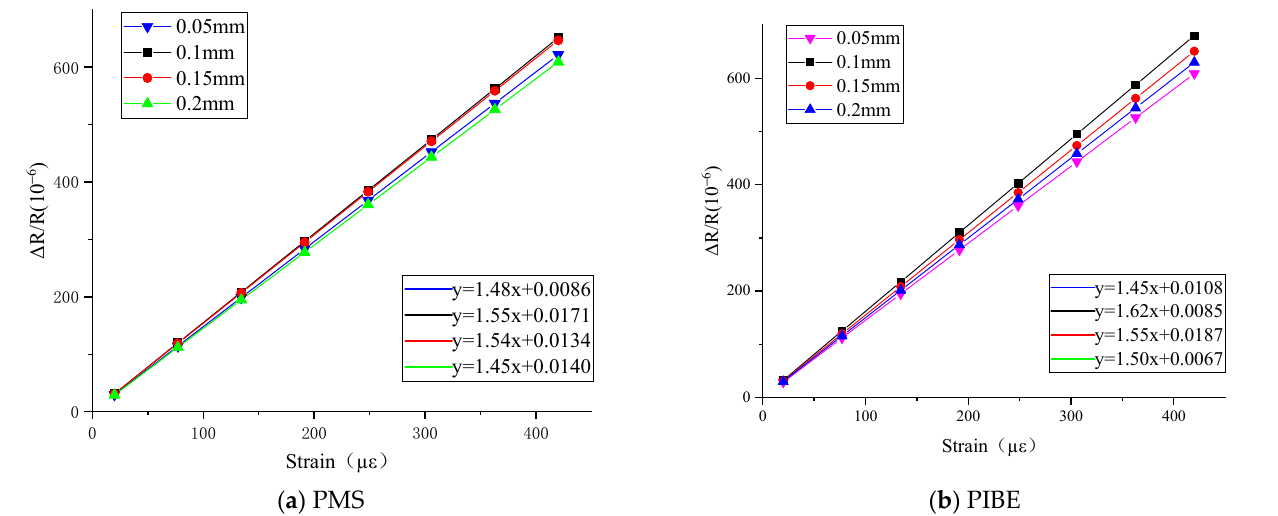
Figure 6. Results of thin-film strain sensors with different grid widths prepared by PMS and PIBE.